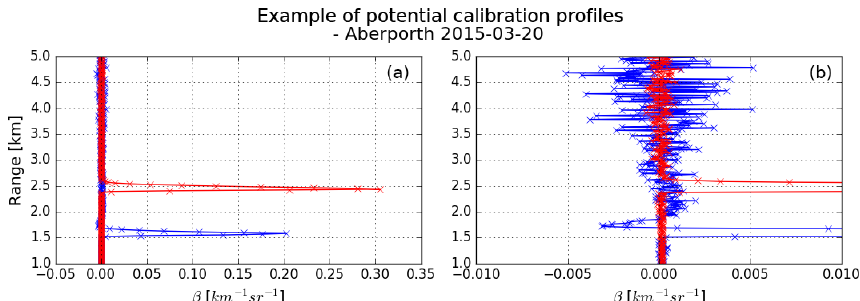
Figure 10. Two profiles of attenuated backscatter that detect liquid cloud from the Lufft CHM15k ceilometer at Aberporth on 20 March 2015 ( b shows same plot on different scale). The profile in blue has a negative overshoot above the cloud, whereas the red profile does not.